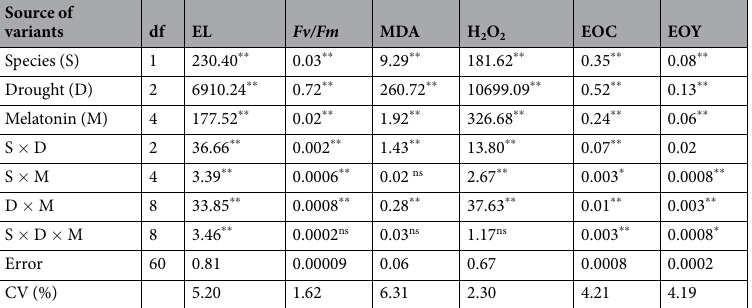
Table 1. Mean square values of the analysis of variance of electrolyte leakage (EL%), Fv/Fm ratio, lipid peroxidation indicated by malondialdehyde (MDA) (nmol g − 1 ), H 2 O 2 content (nmole g − 1 ), essential oil content (EOC %) and essential oil yield (EOY g plant − 1 ). * and ** : Significant at the 5% and 1% probability levels, respectively., ns: Non- Significant, according to the LSD multiple range test at P ≤ 0.05. df, degrees of freedom.